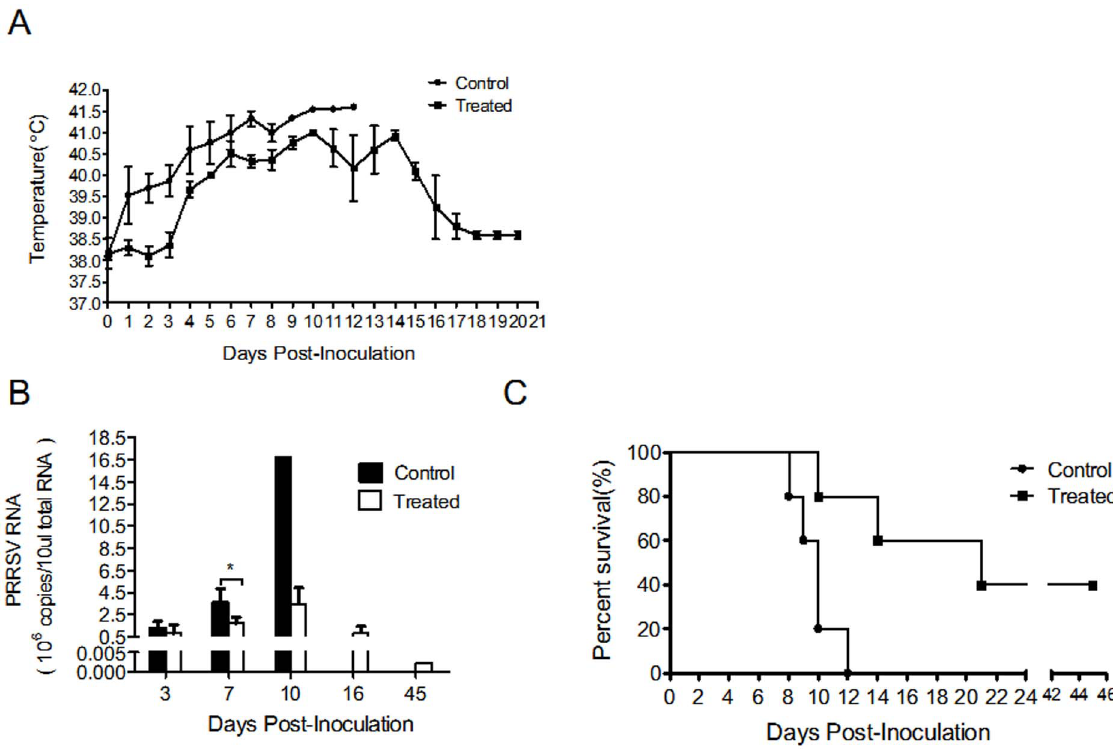
Figure 5. Cryptoporusvolvatus extract inhibits PRRSV infection in vivo. (A) Rectal temperature measurements daily for each group of pigs(n=5)after HP-PRRSV HV strain infection. (B) Analysis of viral loads in sera from each group of pigs. (C) Survive curves of pigs in each group. Data are presented as mean 6 SE (A and B). Statistical significance was analyzed by Student’s t test ; * P , 0.05 ; ** P , 0.01 ; *** P , 0.001 .